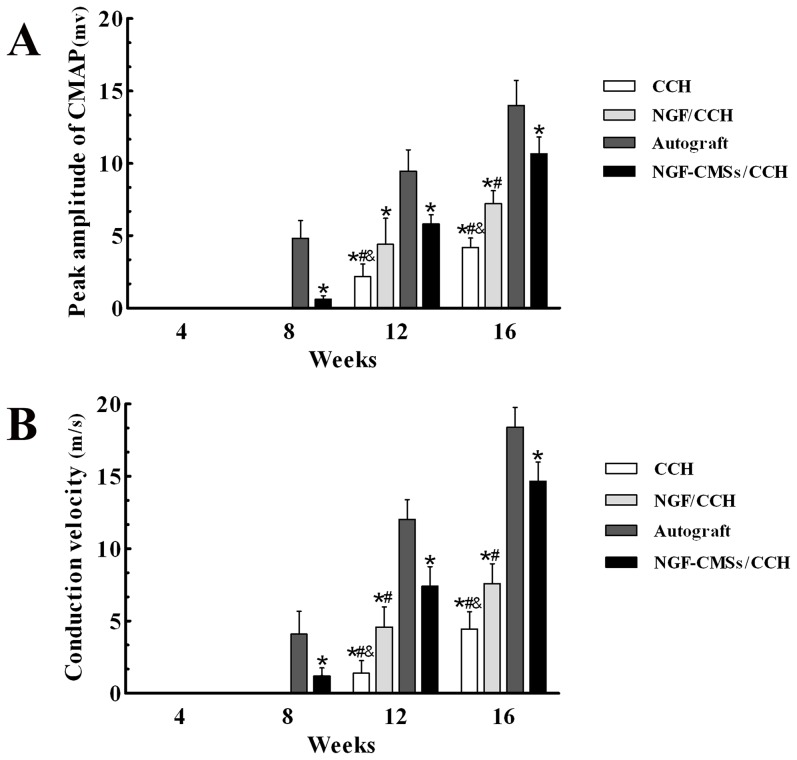
Electrophysiological assessments.All data represent mean ± SD. *p<0.05 between autograft and others (CCH, NGF/CCH, and NGF–CMSs/CCH). #
p<0.05 between NGF–CMSs/CCH and others (CCH and NGF/CCH). &
p<0.05 between NGF/CCH and CCH.